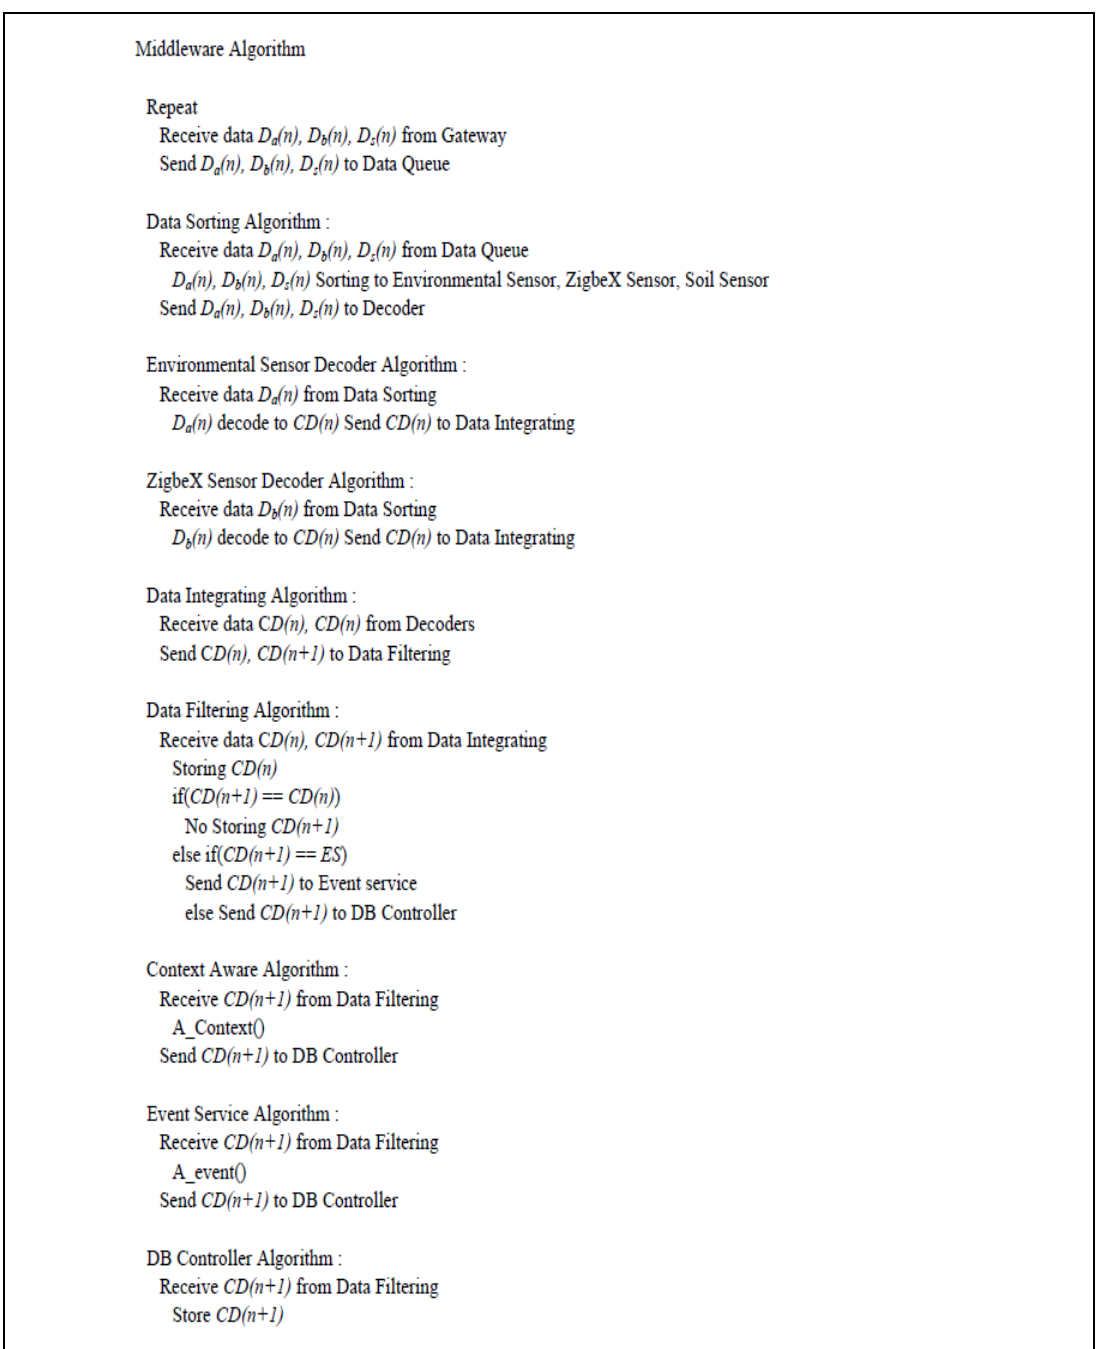
Figure 13. Middleware